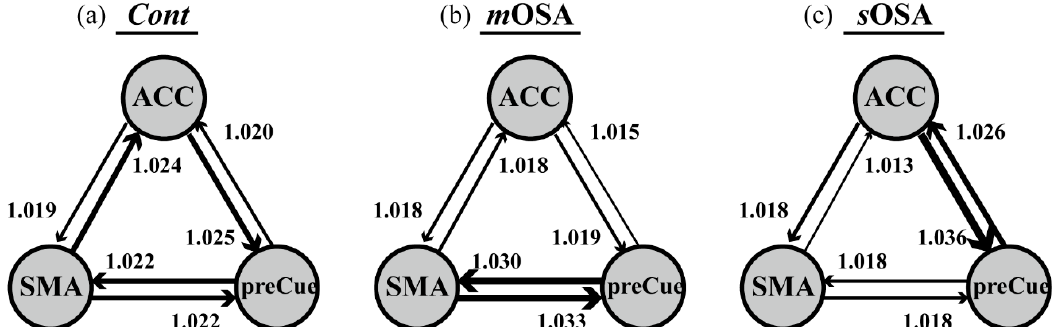
Figure 4. Interactive relationship among the ACC, the precuneus, and the SMA for each group. The thickness of the line denotes the influence between two regions, and the direction of the arrow shows the a ff ective direction from a region to the end of the arrowed region with the impact value. In the Cont group ( a ), the three regions are connected by balanced weights. In patients with m OSA ( b ), the connectivity to the other two regions for the ACC was reduced, and the network balance is tilted toward the connections between the SMA and the precuneus. In patients with s OSA ( c ), the ACC showed increased interactive connectivity to the precuneus, and thus the connection weight is tilted toward the connection of the ACC and the precuneus. This indicates that the pattern of functional connectivity alternates with the severity of OSA, and reflect the vital role of the ACC in the action-monitoring function. Abbreviation: Cont , Control group; m OSA, moderate OSA group; s OSA, severe OSA group; ACC, anterior cingulate cortex; SMA, supplementary motor area; preCue, precuneus; OSA, obstructive sleep apnea.